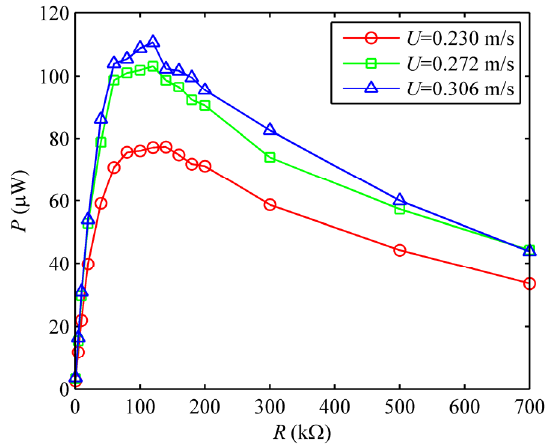
Figure 3. Variations of the output power with resistors at three water speeds.